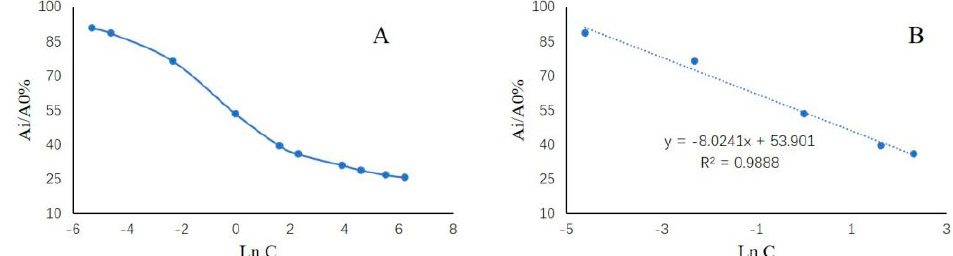
Figure 3. ( A ) Relative absorbance of the designed analytical method as a function of the logarithm of concentration. ( B ) Tetracycline standard curve. Table 1. Results of precision evaluation